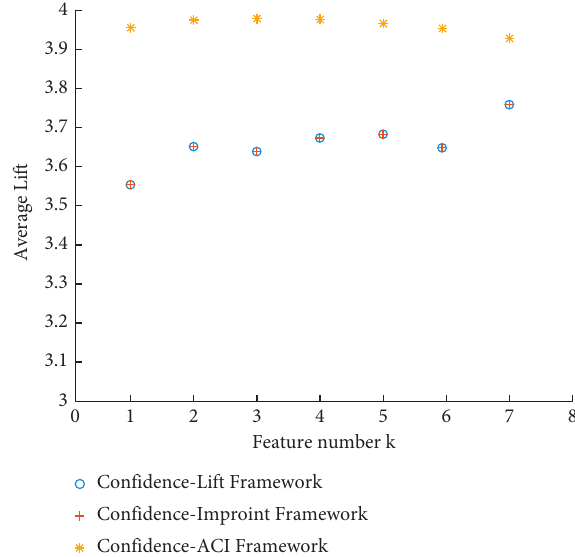
Figure 24: Average lift of different fault diagnosis rule discriminant